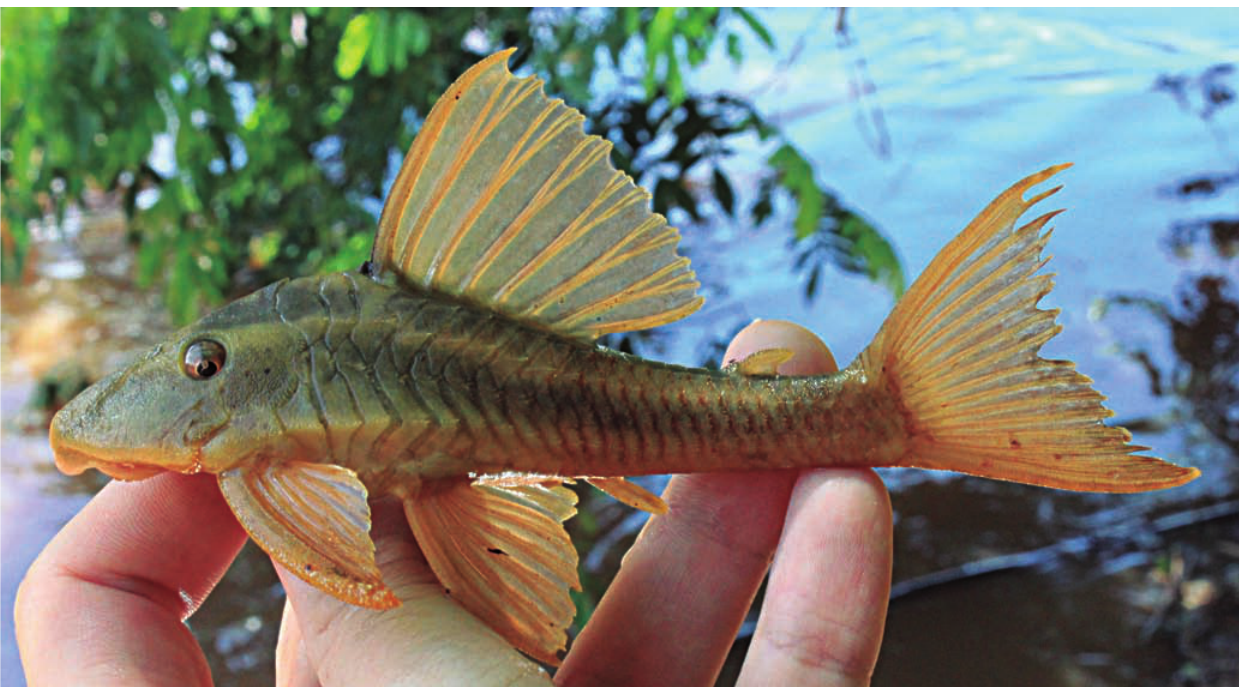
Fig. 14. Color pattern of live specimen of Hypostomus khimaera , ZUFMS-PIS 3738, 10.6 mm SL, rio Aquidauana, Mato Grosso do Sul, Brazil, showing the dark tan stripe along midline of flank and diffuse spots on the